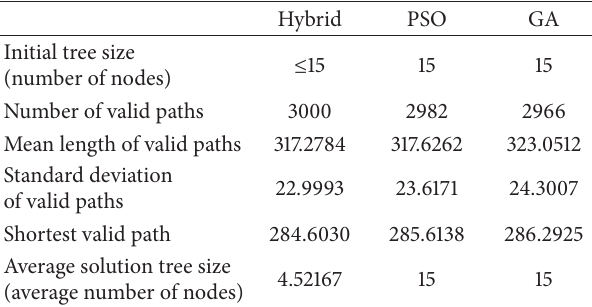
Table 6: Comparison in performance among the proposed hybrid approach, PSO, and GA for test environment